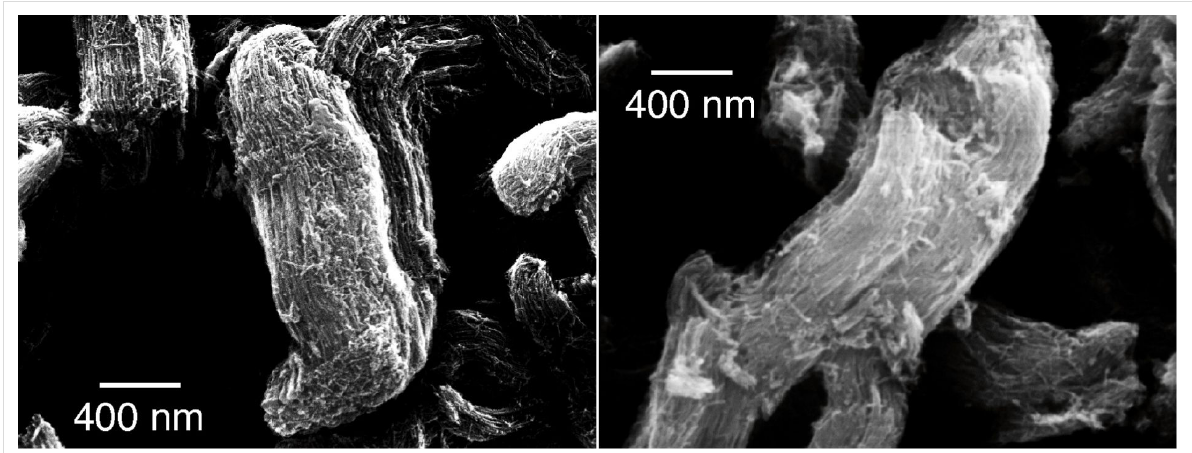
Figure 3: SEM images of the Fe 2 O 3 nanowires deposited on a Si surface before (left) and after (right) thermal treatment at 650 K.